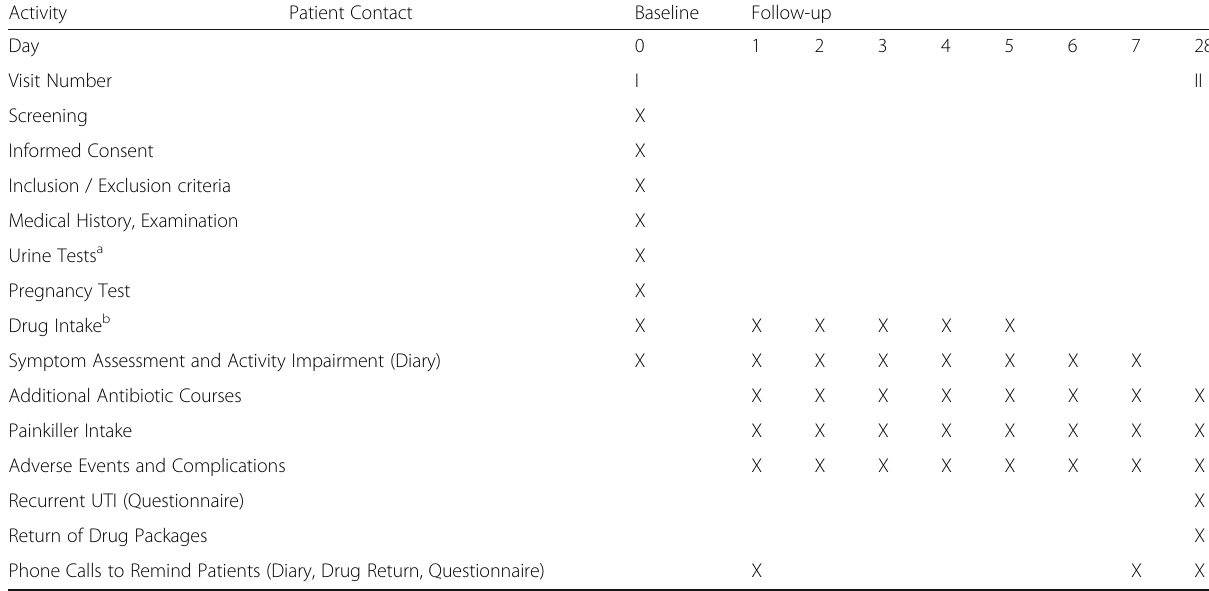
Table 1 Participant timeline in